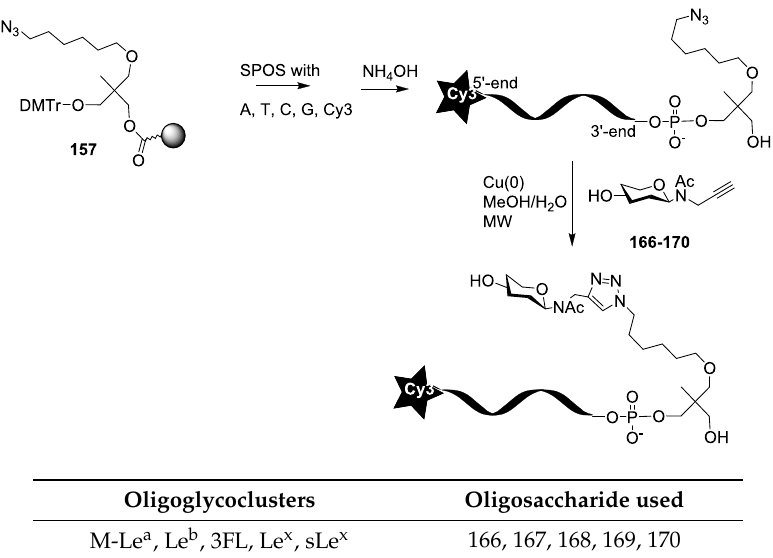
Scheme 5. Synthesis of oligosaccharide-oligonucleotide conjugates (M-series).